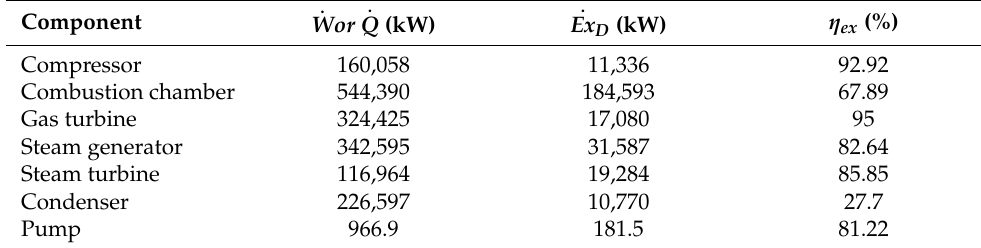
Table 9. Energy and exergy analysis of Config. 1.